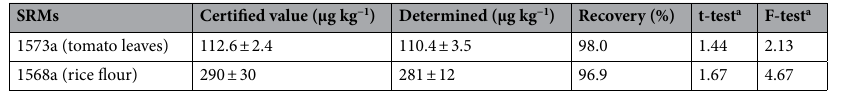
Table 5. Determination of the As in two standard reference materials after application method (N:5). a Theoretical value for t- and F-values for 5 degrees of freedom and 95% confidence limits are 2.57 and 6.39 respectively.